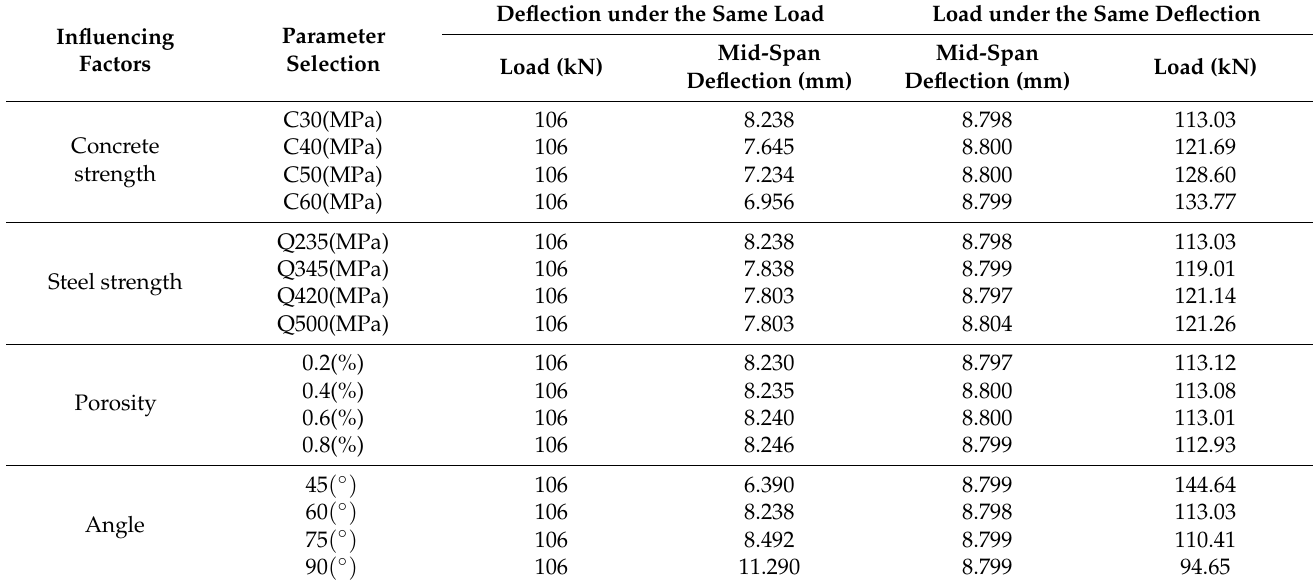
Table 4. Summary of composite beam model parameters and